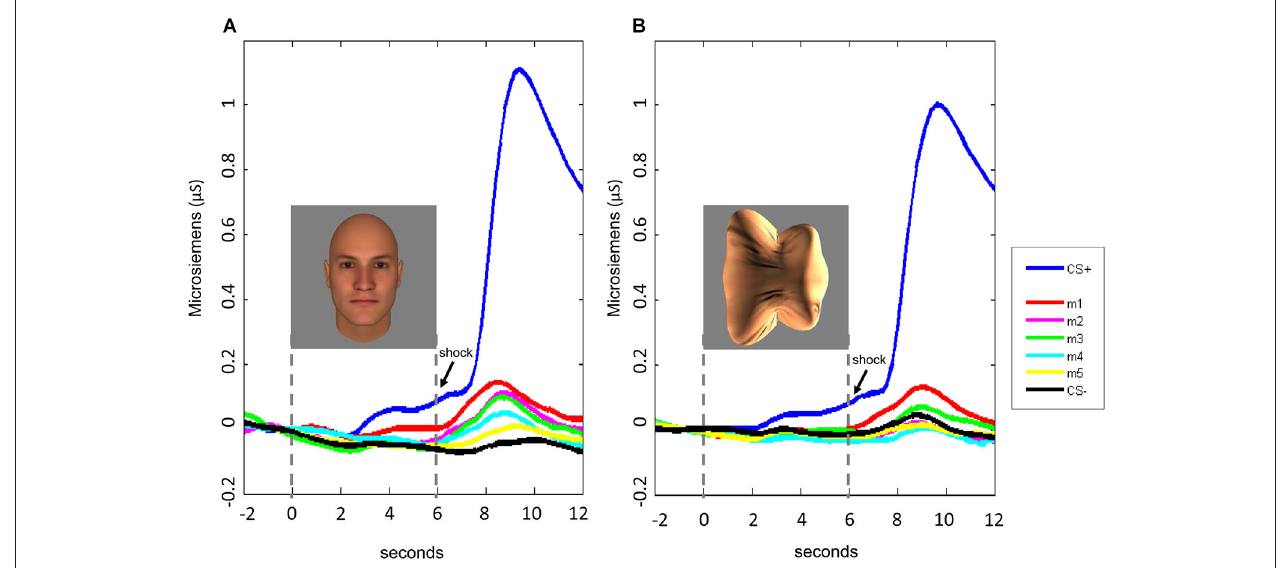
FIGURE 5 | Time course of SCRs during the fear generalization procedure . In both Experiment 1 (A) and Experiment 2 (B) , fear generalization to the morphs was greatest following stimulus offset, peaking at approximately 8–9 s following stimulus onset. For the data displayed here, the baseline was corrected for all stimulus conditions by adjusting the mean response during the 2-s interval before the stimulus onset to